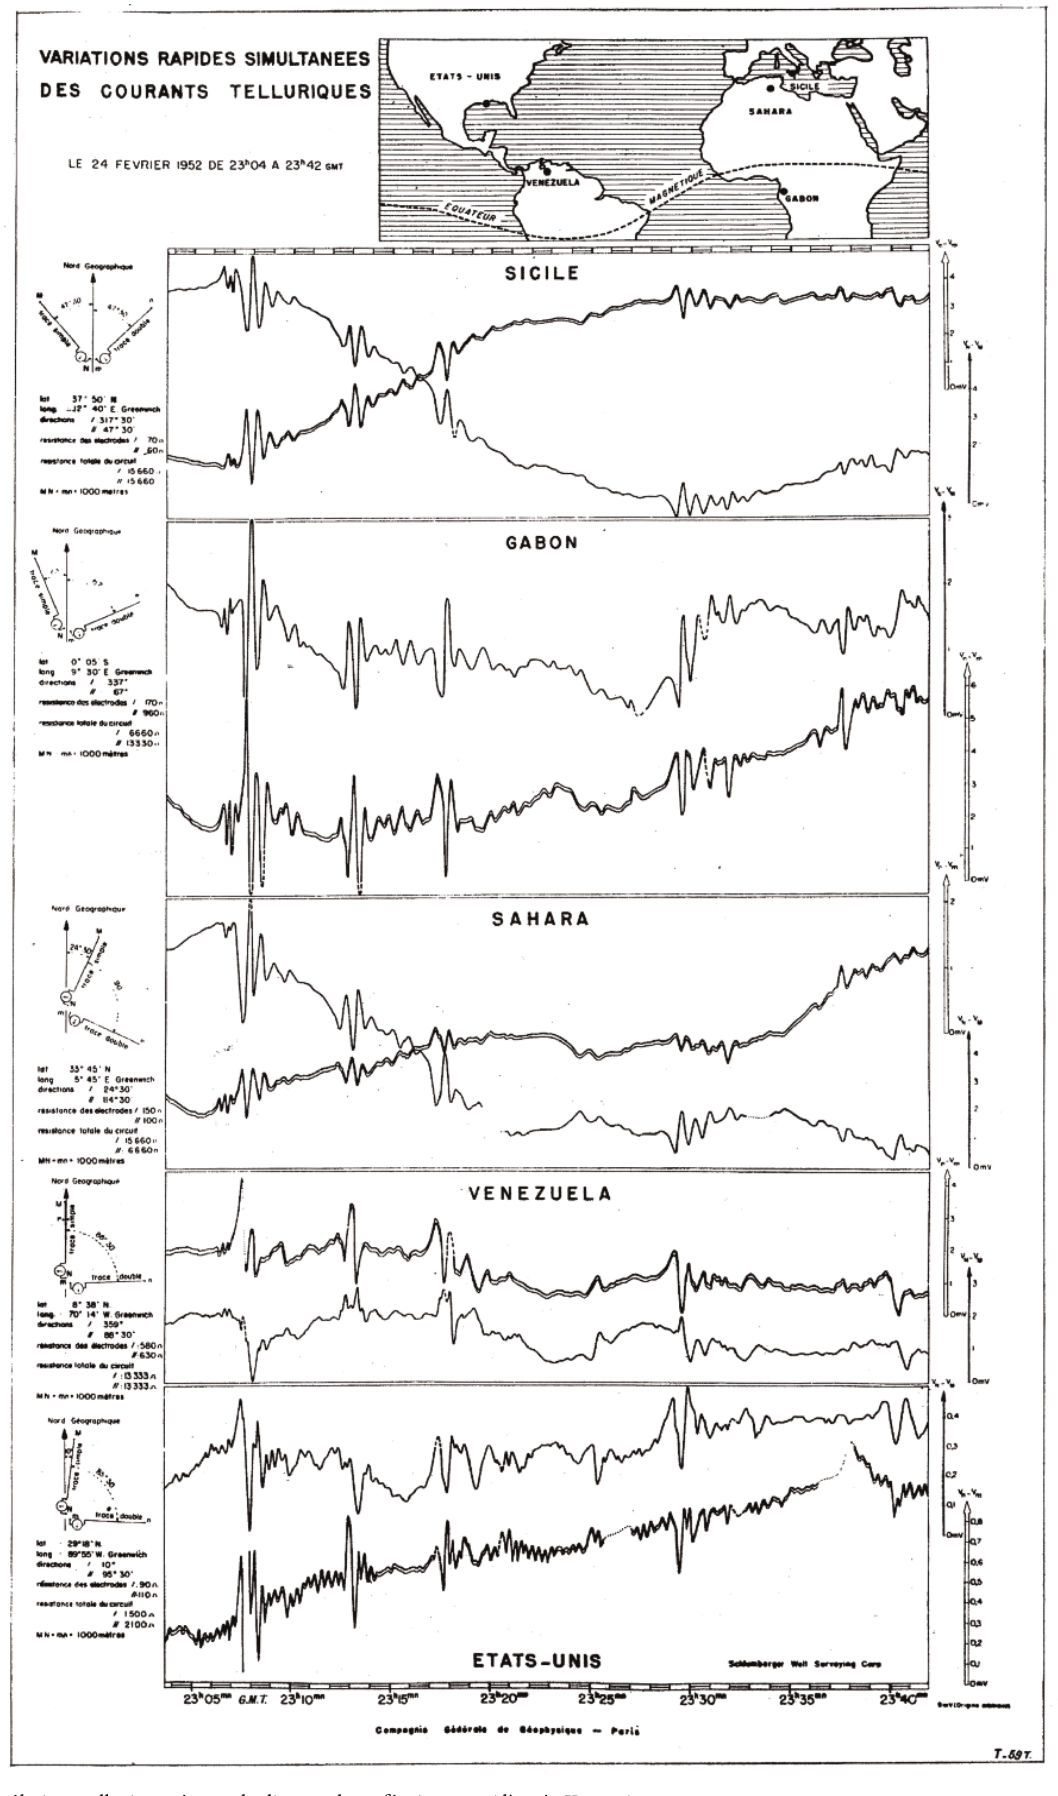
Figure 10. Corrélations telluriques à grande distance le 24 février 1952 (d’après